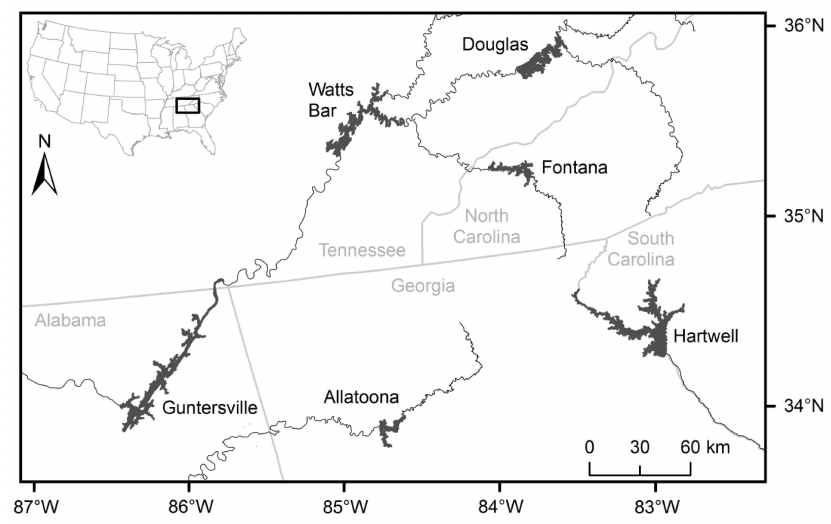
Figure 1. Locations of six southeastern U.S. hydropower reservoirs sampled for greenhouse gas emissions in 2012. Table 1. Morphological and hydrological characteristics of six study reservoirs in the southeastern